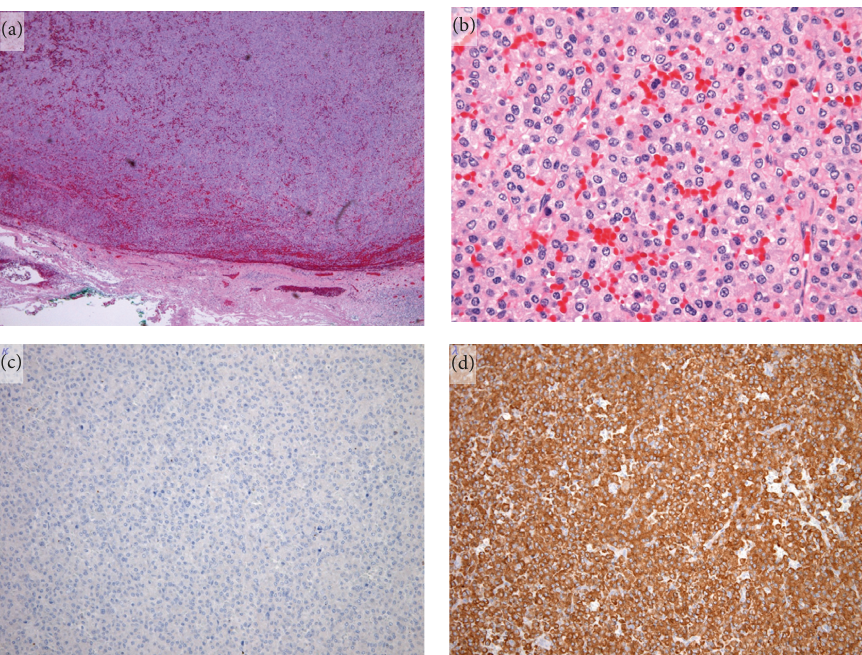
Figure 4: Histopathological findings for transorally resected nasopharyngeal tumor. HE staining: low magnification (a) and high magnification (b). Proliferation of plasma cells and unevenly distributed nuclei are observed. Immunostaining shows negative results for κ (c) and positive results for λ